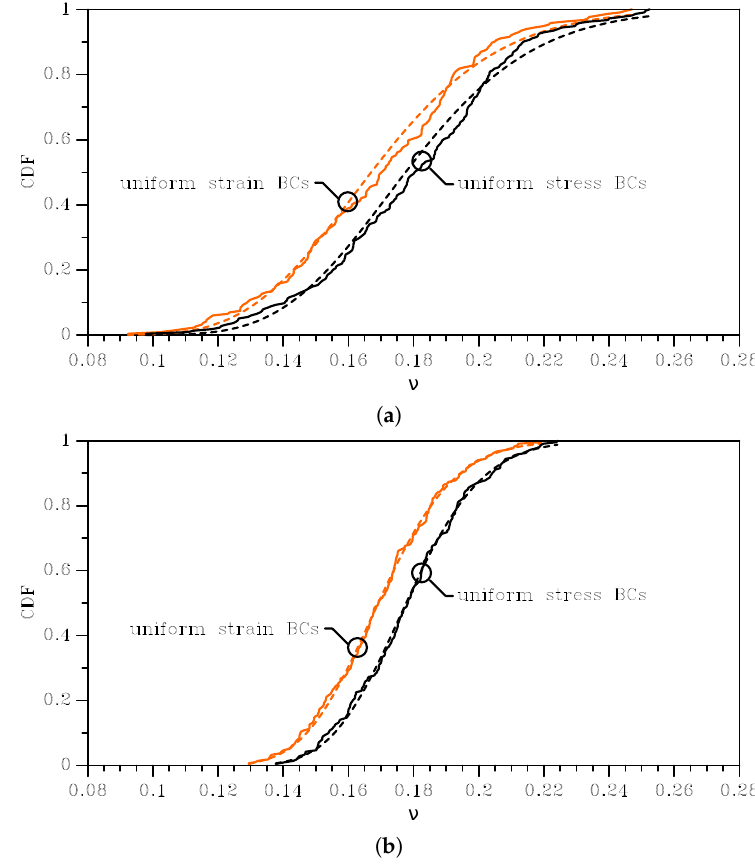
Figure 5. Effects of SVE size and BCs on the cumulative distribution function of the homogenized Poisson’s ratio ν : ( a ) 2 × 2 µ m 2 SVE and ( b ) 3 × 3 µ m 2 SVE. Continuous lines represent the results of MC analyses, whereas dashed lines are the relevant lognormal